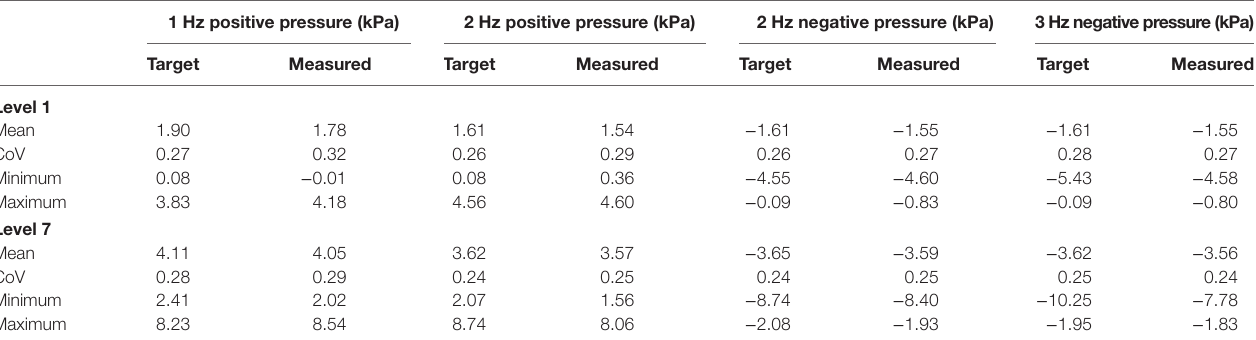
TaBle 1 | statistics of the target and measured wind pressure at intensity levels 1 and 7. 1 hz positive pressure (kPa) 2 hz positive pressure (kPa) 2 hz negative pressure (kPa) 3 hz negative pressure (kPa) Target Measured Target Measured Target Measured Target Measured level 1 Mean